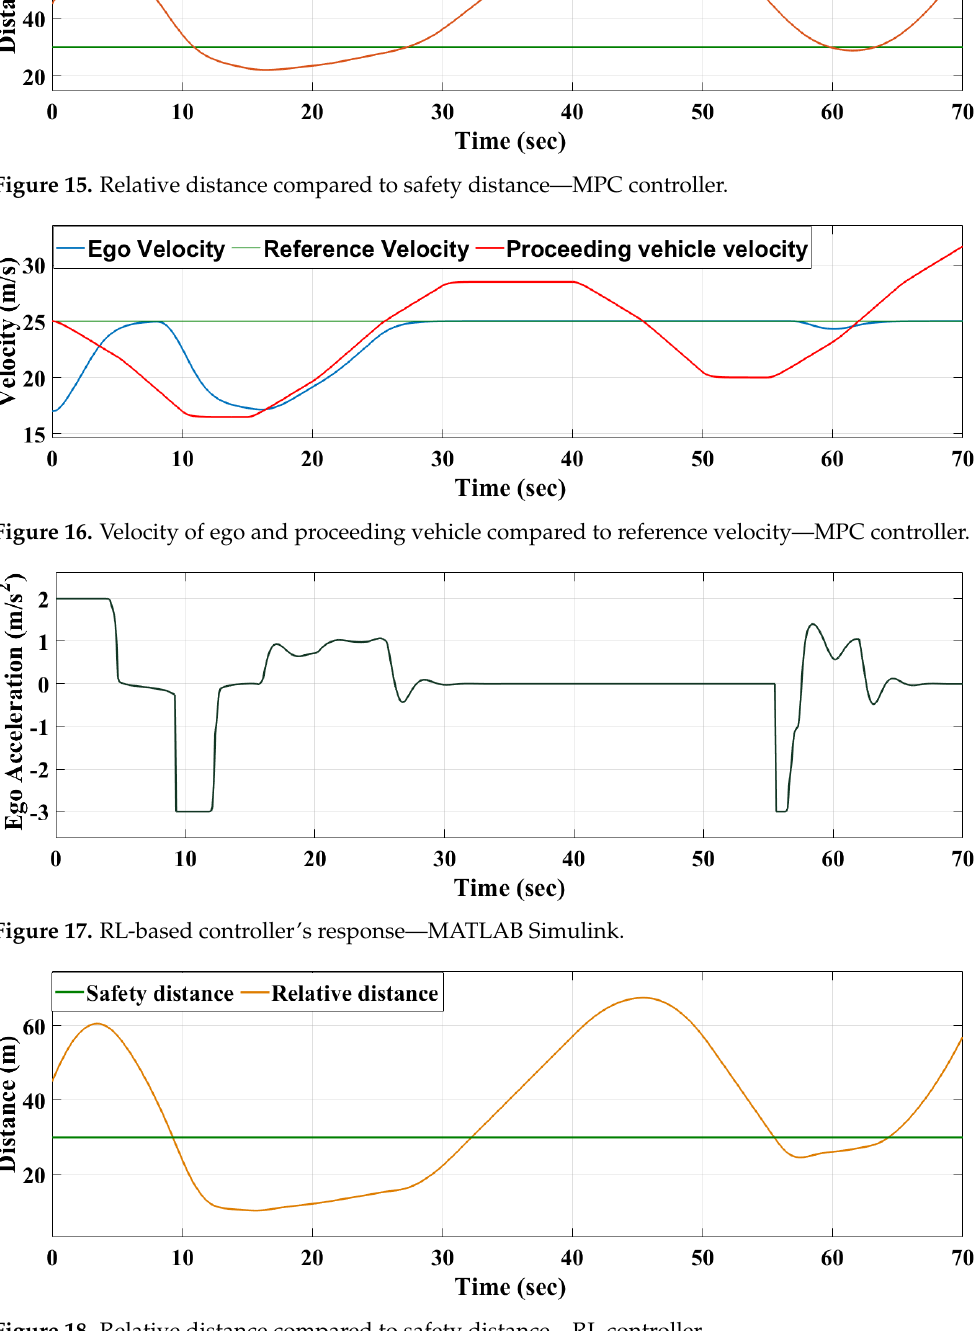
Figure 18. Relative distance compared to safety distance—RL